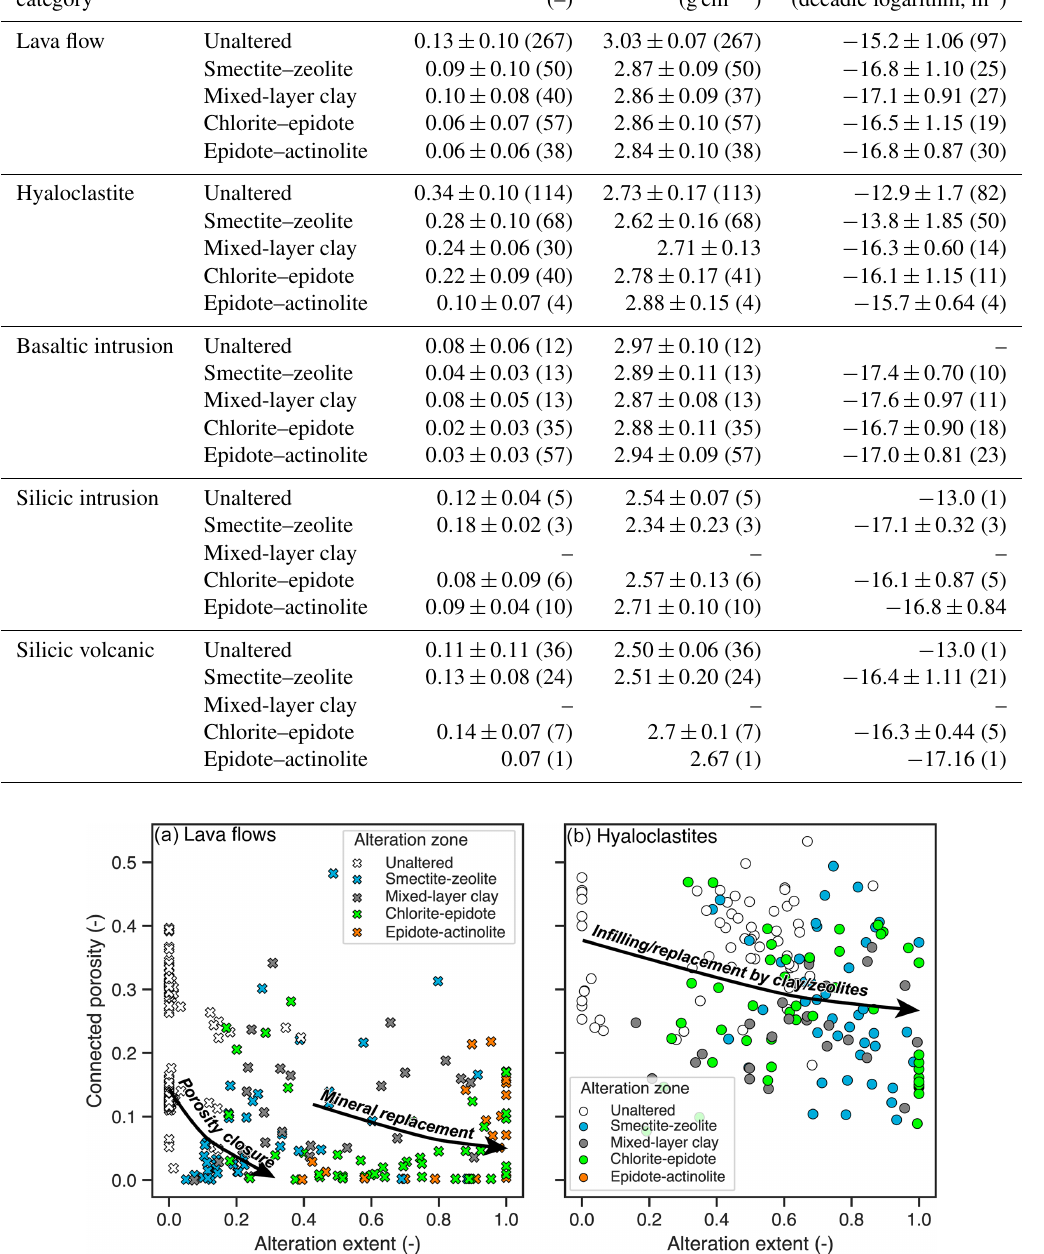
Figure 10. The relationship between alteration extent, as determined by petrographic observations and XRD, and the connected porosity for (a) lava flows and (b) hyaloclastites. High-porosity rocks such as hyaloclastites undergo near-complete mineral replacement in the smectite– zeolite facies, whereas rocks with low porosity, such as lava flows, undergo porosity closure after a limited extent of alteration. Rocks altered to chlorite–epidote or epidote–actinolite facies show higher alteration extents because of replacement of primary minerals and secondary